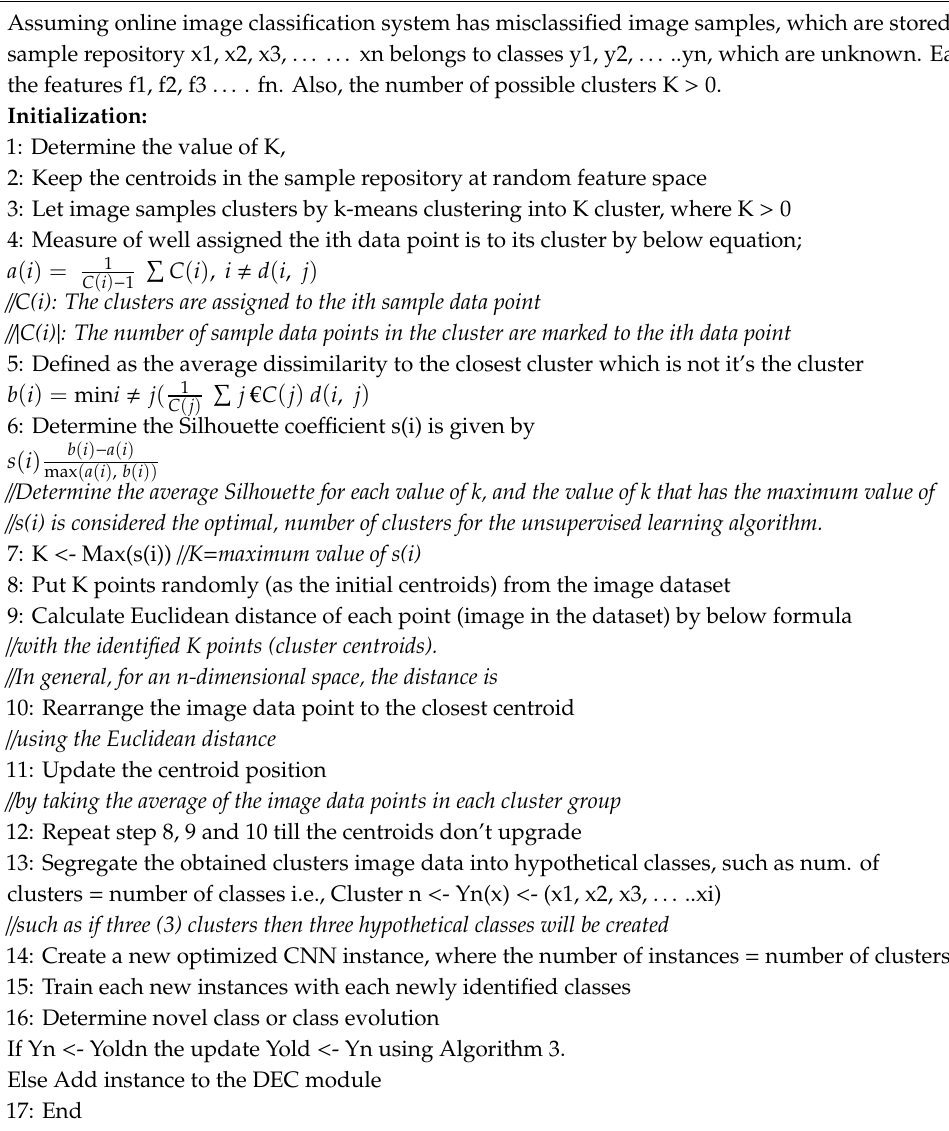
Algorithm 2: Online Training Module of Ameliorate Adaptive CNN Ensemble